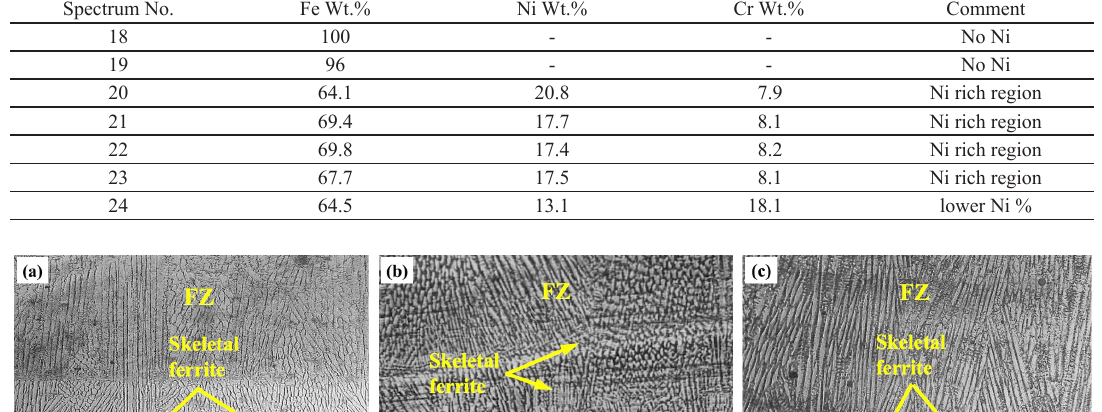
Table 4. Weight percentage of Fe, Ni and Cr of the spectrums in Figure 3a. Spectrum